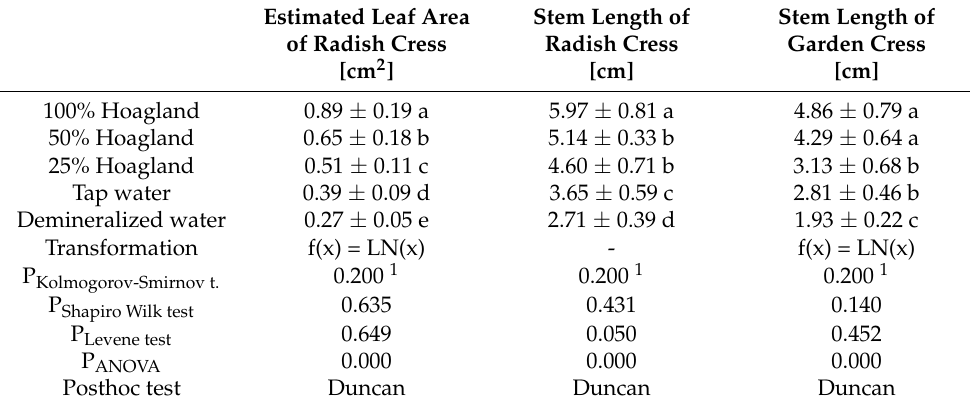
Table 4. Estimated area of cotyledons of radish cress and stem length of garden and radish cress. Different letters within a column indicate significant differences.